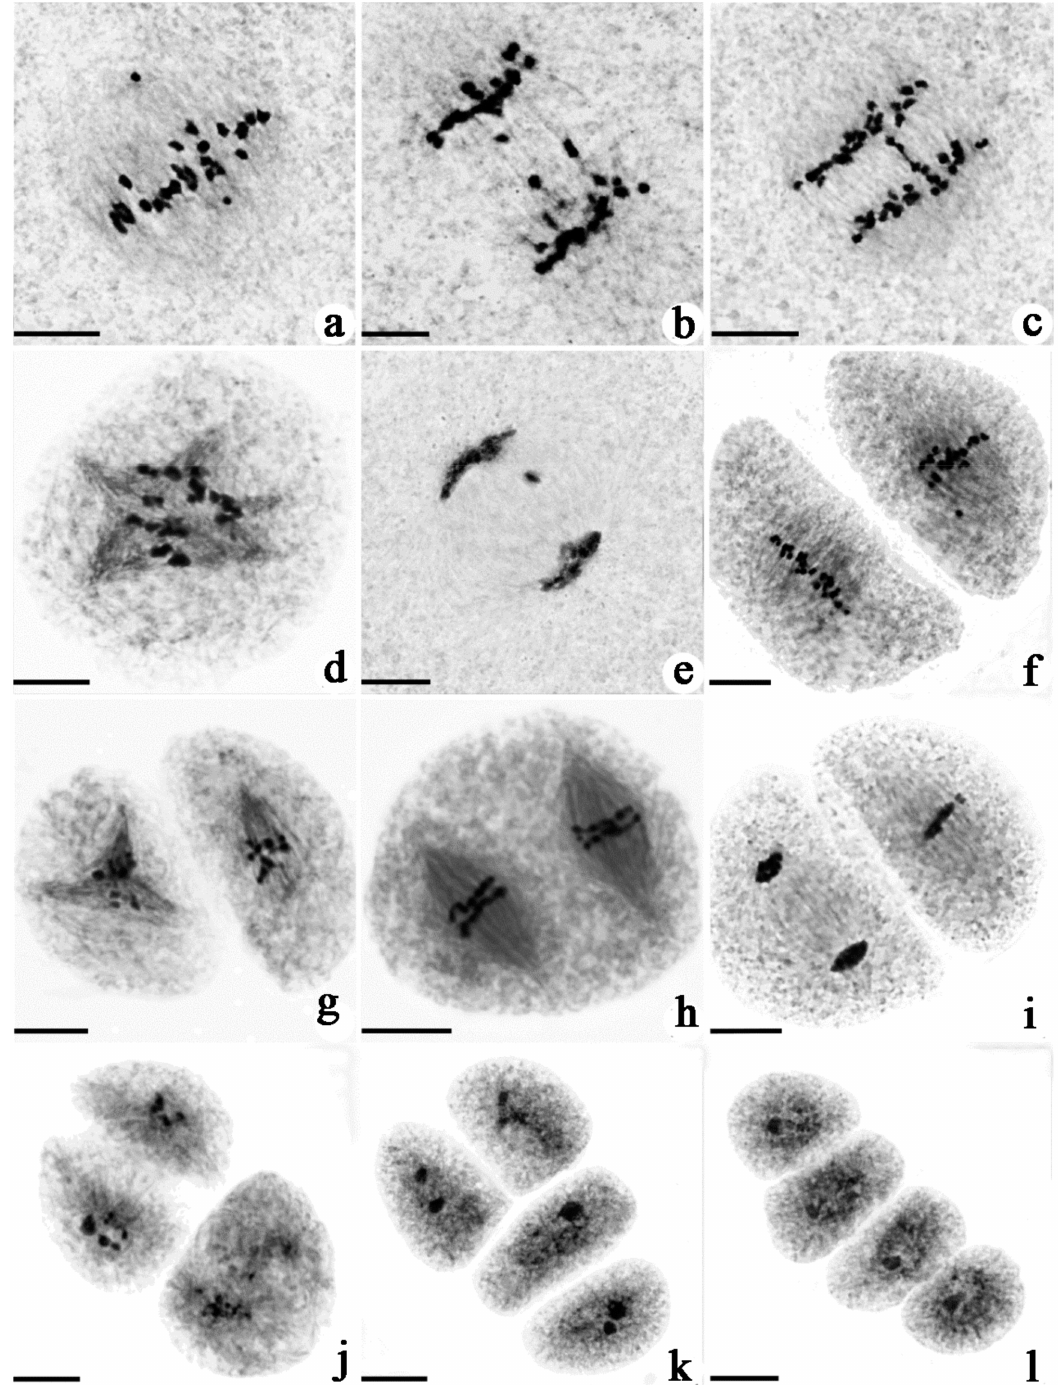
Figure 2. Abnormal chromosome behavior during pollen mother cells meiosis in JD. ( a ) Chromosome lagging at metaphase I; ( b , c ) chromosome straggling at anaphase I; ( d ) multipolar spindle at metaphase I; ( e ) micronuclei at telophase I; ( f ) chro- mosome lagging at metaphase II; ( g – i ) abnormal cell shape and asynchronous division of chromosomes during meiosis II; ( j ) abnormal triad; ( k ) abnormal “T” shape tetrad; ( l ) abnormal line shape tetrad. Bars = 10 µ m. A total of 6.37 Gb, 6.26 Gb, 45.97 Gb and 31.33 Gb clean data were obtained by bulked segregant RNA-seq (BSR-seq) of F 4 generation from H3, T452, JG bulk and JD bulk, respectively. The Q30 base percentage was above 94.02% and the GC content in each sample sequencing data was between 55 and 57% (Table S4). In this generation, 65,202 SNPs were obtained for ∆ SNP-index correlation analysis, which mapped